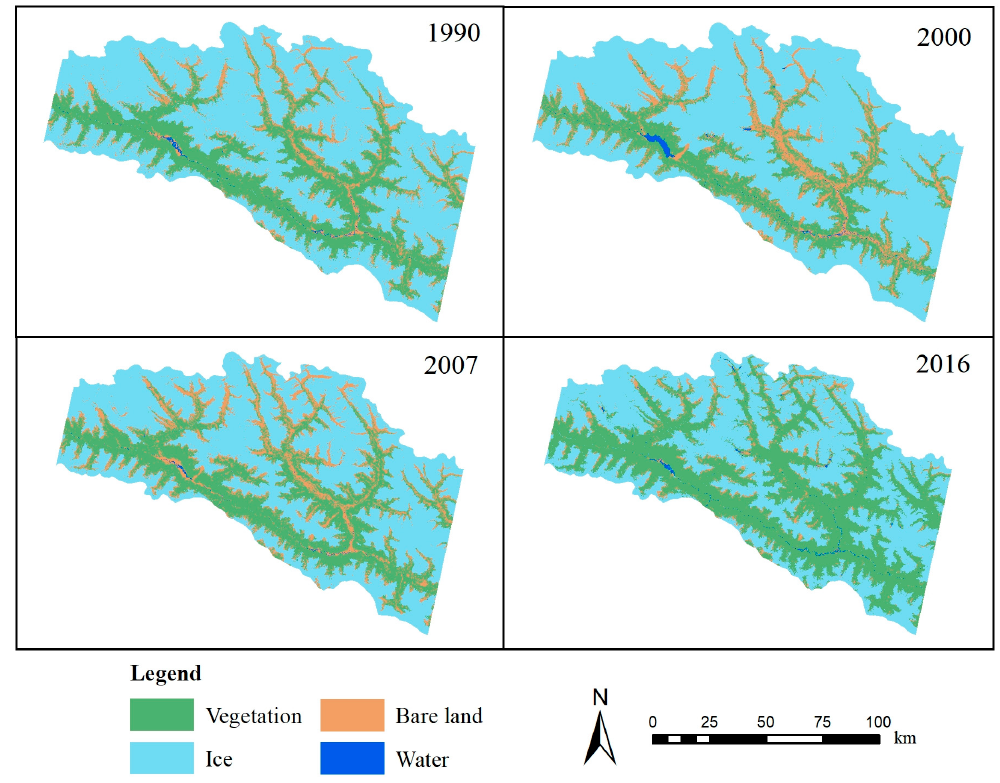
Figure 3. Cloudless land cover maps for the four years: 1990, 2000, 2007 and 2016.